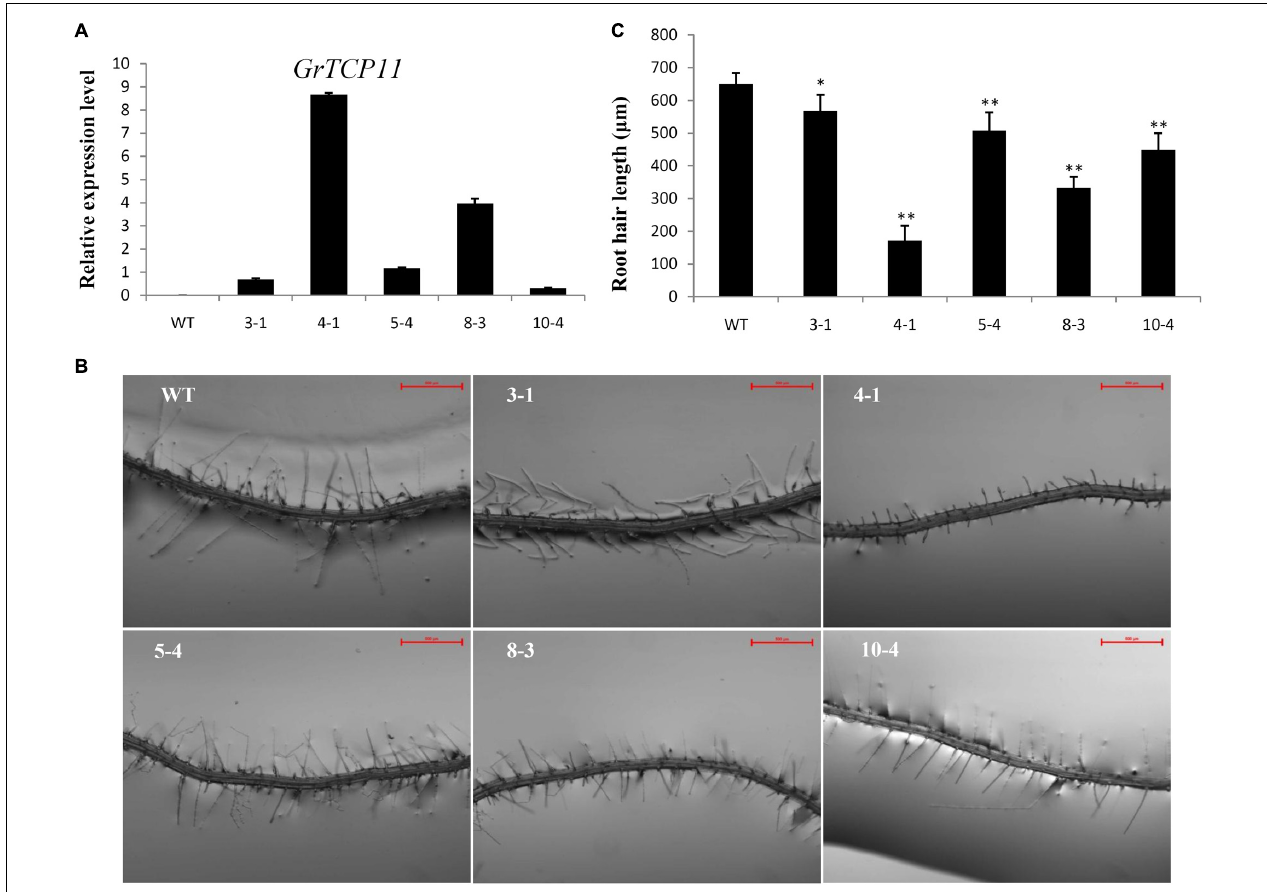
FIGURE 4 | Expression level and morphological alterations of the root hairs in Arabidopsis transgenic plants overexpressing GrTCP11 . (A) Relative expression level of GrTCP11 in transgenic lines (3-1, 4-1, 5-4, 8-3, and 10-4) and wild-type plants; expression of GrTCP11 was calculated relative to reference AtACT2 expression; error bars represent the standard deviation of three biological replicates. (B) Root hairs in the mature area of taproots of 7-day-old transgenic lines and wild-type plants; scale bars = 500 µ m. (C) Length of the root hairs of 7-day-old seedlings within the mature zone; data are mean of 100 root hairs; ∗ P < 0.05; ∗∗ P < 0.01 relative to the wild-type, using Student’s t test.